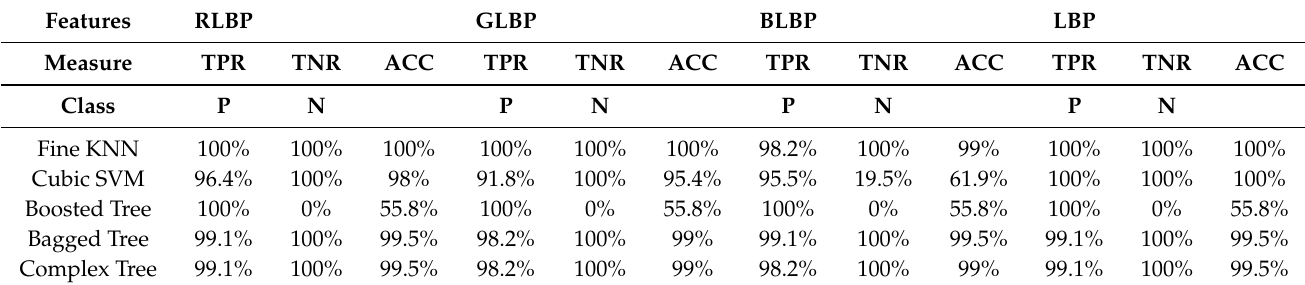
Table 7. Results obtained with different classifiers using LBP features for image-level classification.